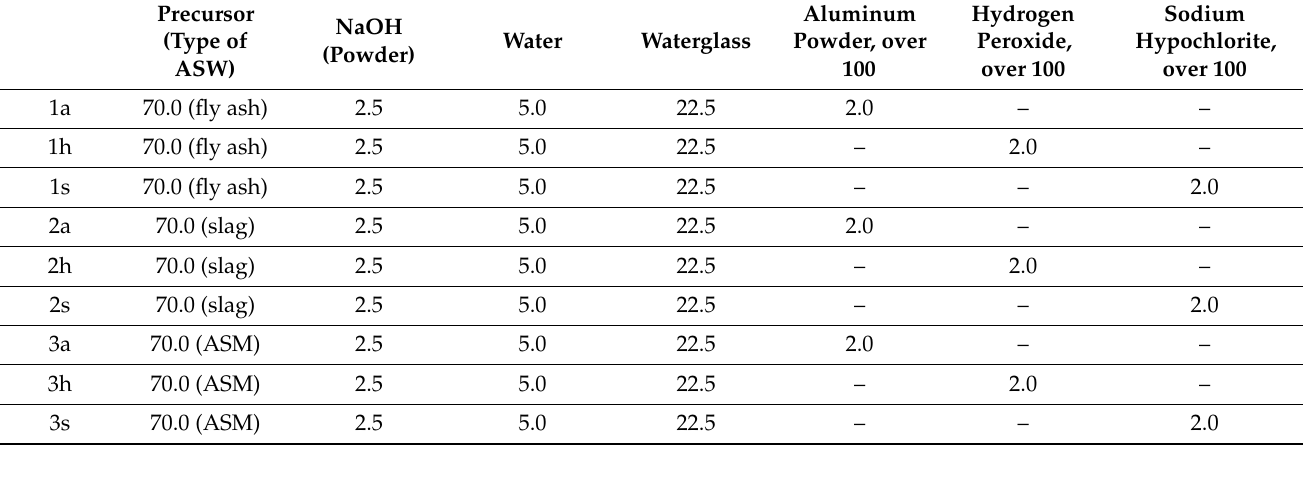
Table 1. Component composition of the raw mixture, wt.% .